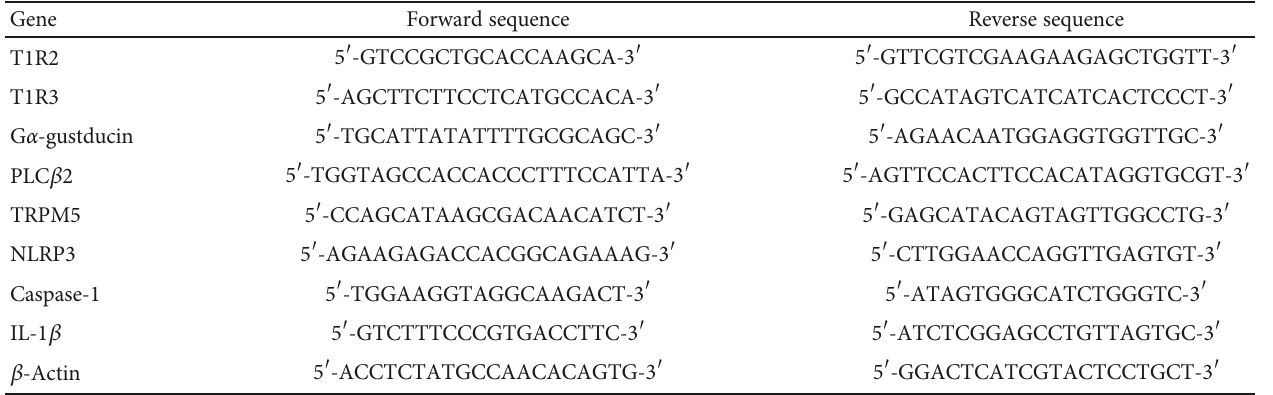
Table 1: Primer sequences for